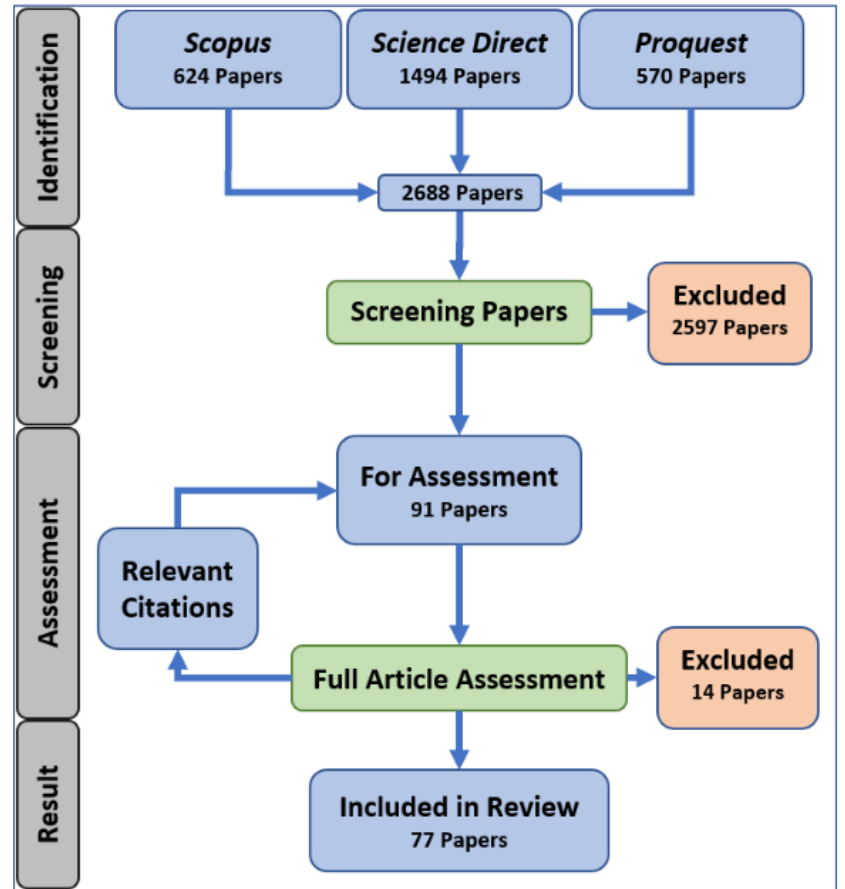
Figure 3. The flow diagram for the method of paper selection.